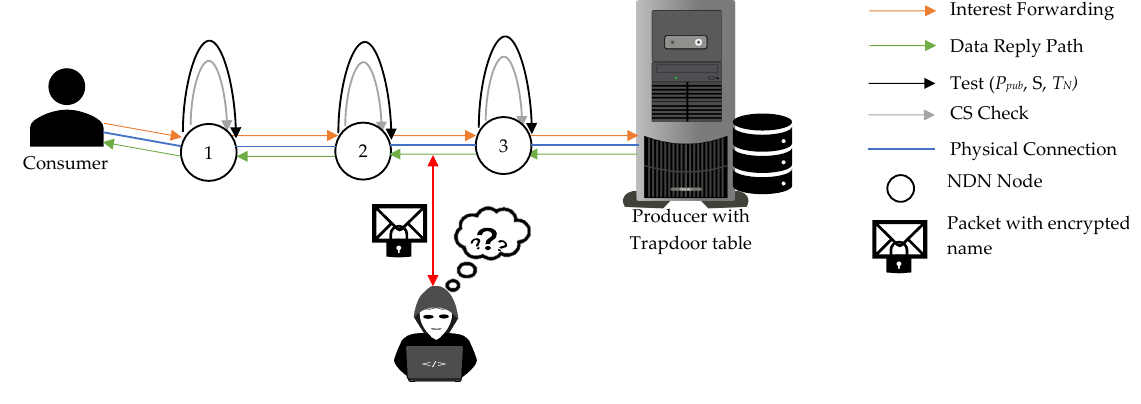
Figure 5. Thread model to PEKS-based NDN.